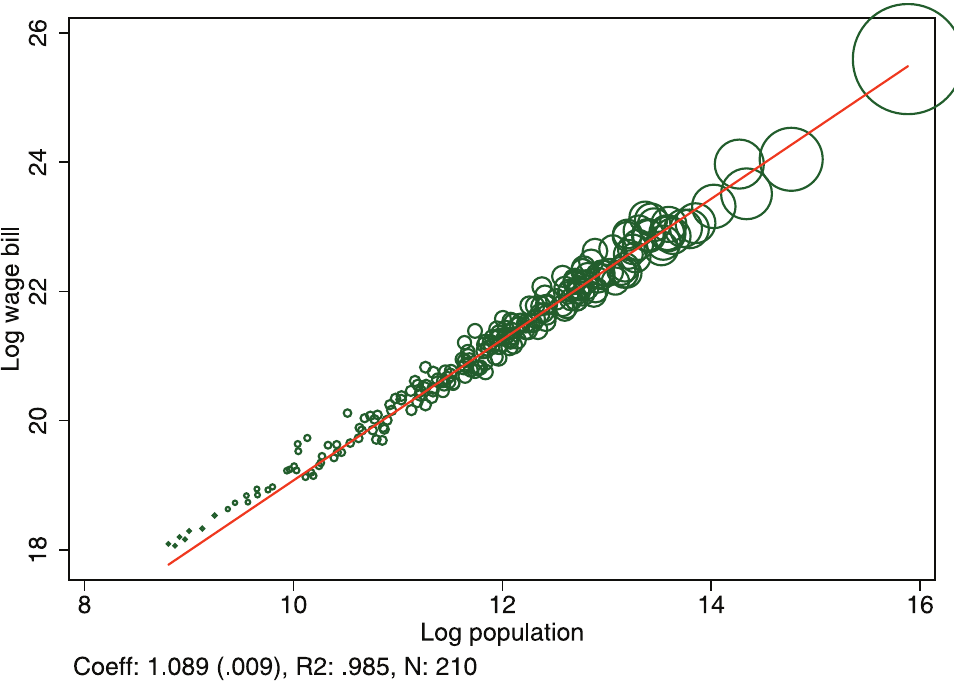
Fig 1. Urban wage premium. Total productivity as measured by the wage bill and its scaling with respect to city population. Each dot represents a UK Travel to work area. The scaling coefficient was estimated by OLS and the standard error is shown in